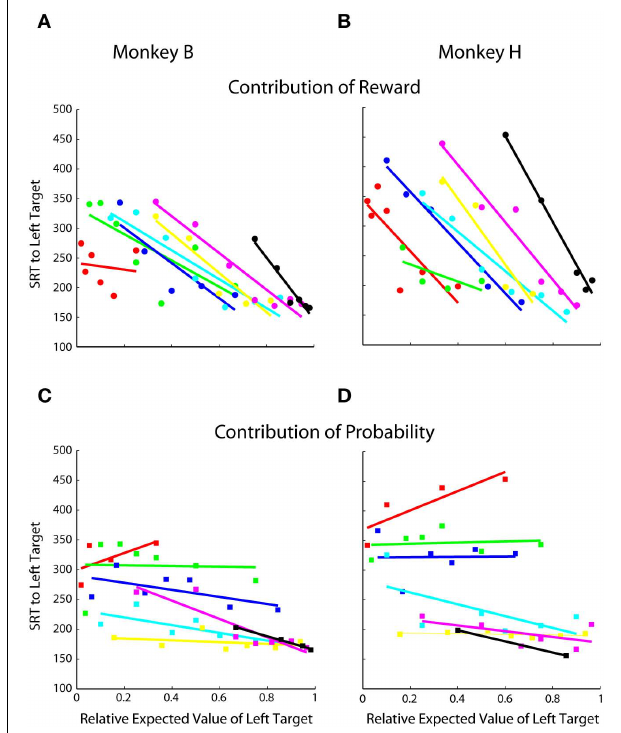
FIGURE 5 | Contribution of reward magnitude and probability to SRT. Each point represents 150–225 trials of a specific prospect collapsed across two to three blocks of trials. Same single-target data as Figures 4C,D . (A,B) Contribution of reward magnitude. Each color indicates a group of prospects with the same probability.Within each color, each point represents a different reward magnitude condition. In order, red was the lowest probability, followed by green, blue, cyan, yellow, magenta, and black was the highest. See Table 1 for exact values. (C,D) Contribution of reward probability. Each color indicates a group of prospects with the same reward magnitude and each point within the colored groups represents a different reward